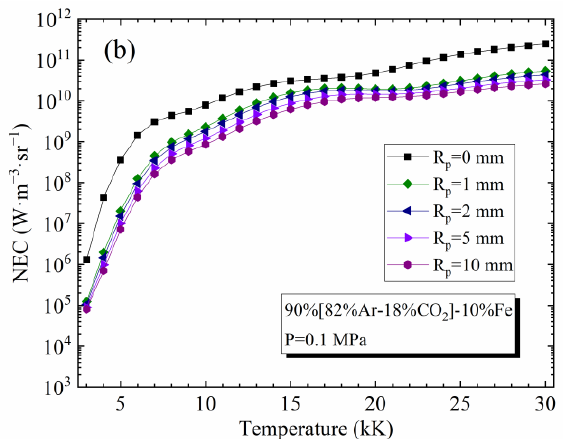
Figure 3. Influence of the plasma radius R p on the NEC for the plasmas at atmospheric pressure: ( a ) 82%Ar-18%CO 2 mixture; ( b ) 90%[82%Ar-18%CO 2 ]-10%Fe (molar proportions).